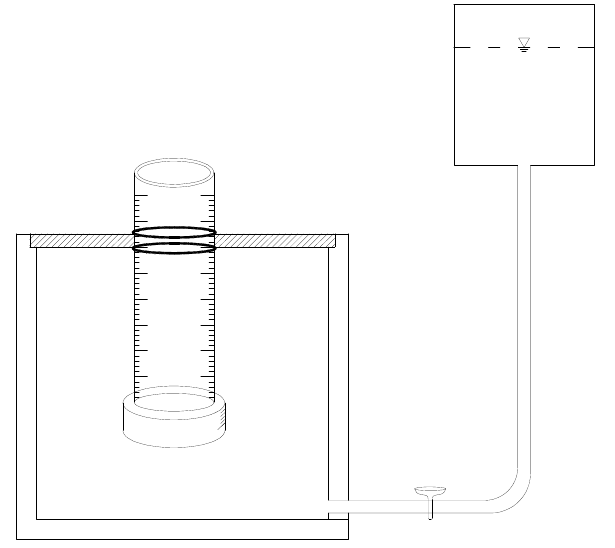
Figure 2. Apparatus of the effective infiltration depth test.